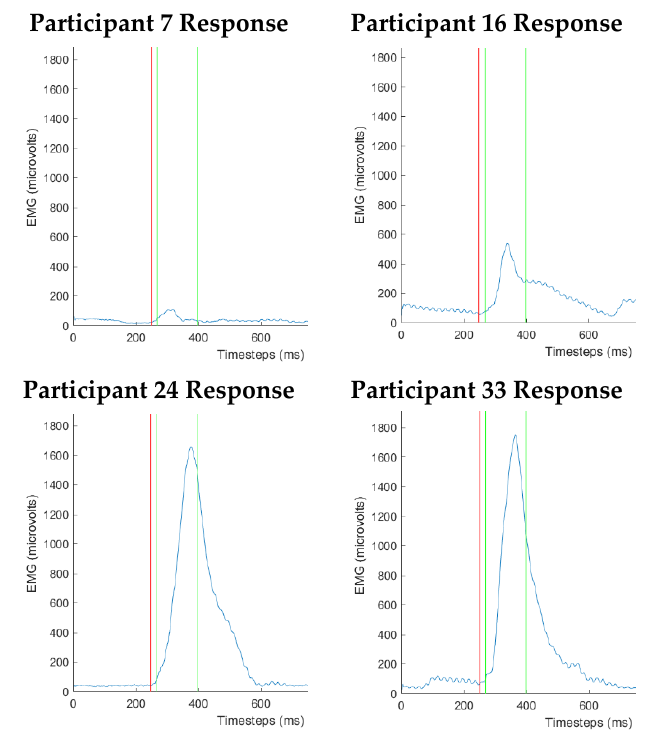
Figure 4. Different participants viewing the same normatively rated visual imagery can produce highly variable f-EMG responses. Key: Slide Number: 3015, Description: Accident, Category: Unpleasant, Valence Mean SD: (M = 1.52, SD = 0.95). Note: The blue line is a raw response from a participant; the red line is the startle noise; the green lines are the response window.